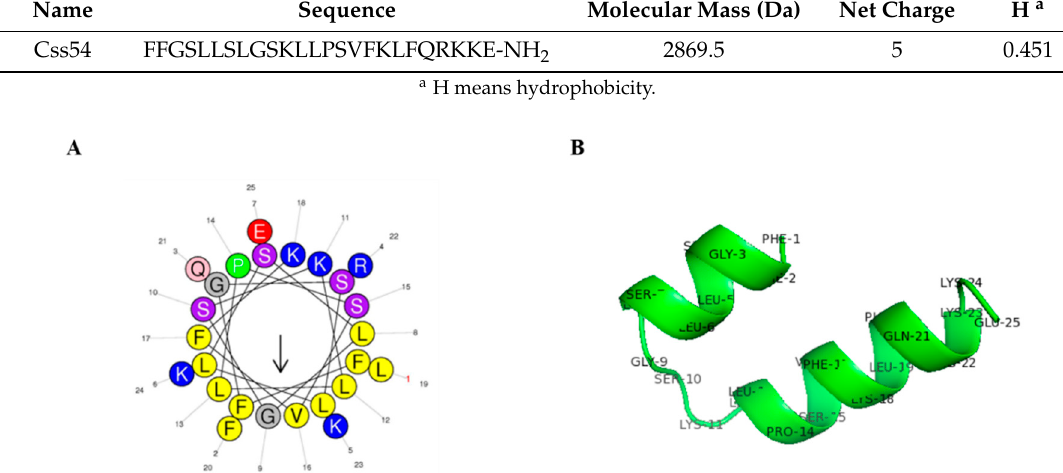
Figure 1. Structure analysis of Css54. ( A ) Helical wheel diagram of Css54 was obtained from the HeliQuest site (https://heliquest.ipmc.cnrs.fr/cgi-bin/ComputParams.py). ( B ) Three-dimensional structure of Css54 was predicted by PEP-FOLD3 and displayed by PyMOL.